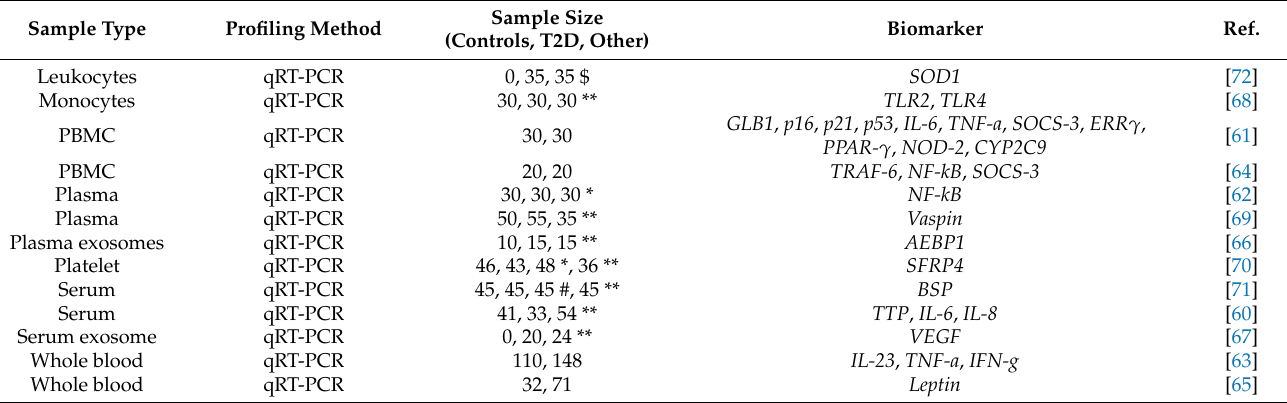
Table 5. Transcriptomics biomarkers from blood samples for